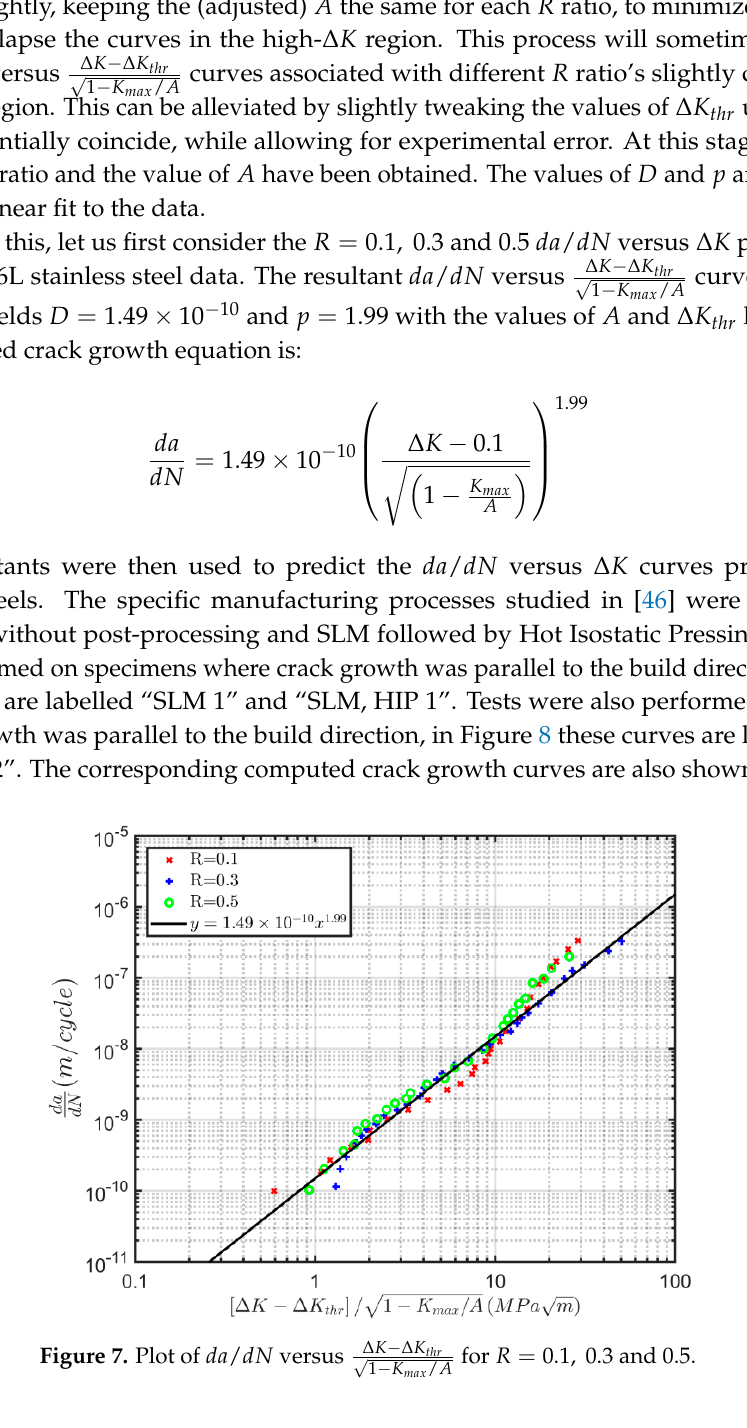
Figure 7. Plot of (cid:1856)(cid:1853)/(cid:1856)(cid:1840) versus (cid:2940)(cid:3012) (cid:2879) (cid:2940)(cid:3012) (cid:3295)(cid:3283)(cid:3293)